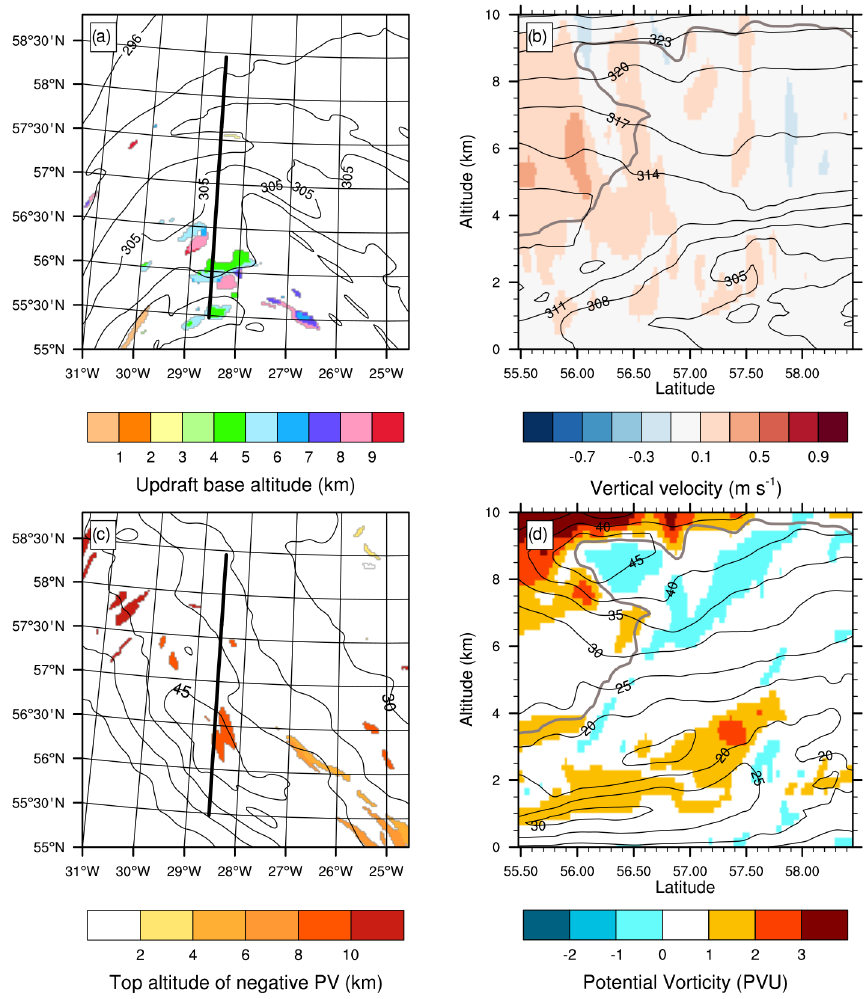
Figure 10. As in Fig. 9 but for the NODIA